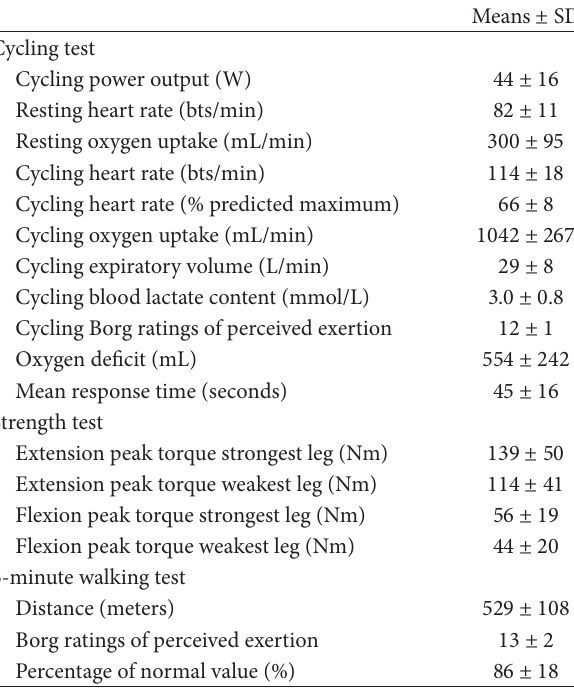
Table 1: Subject characteristics. Table 2: Exercise